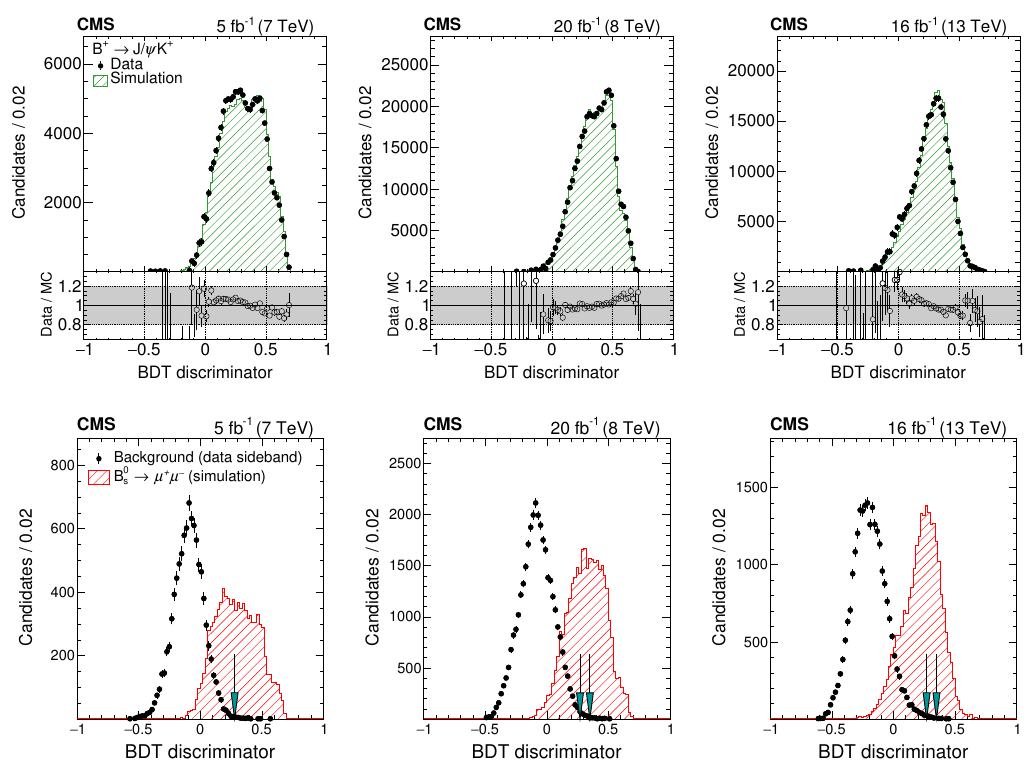
Figure 4 . (Top row) Comparison of the analysis BDT discriminator distributions for B + ! J = K + in background-subtracted data and MC simulation in the central channel for 2011 (left column), 2012 (middle column), and 2016B (right column). The lower panels display the ratio of the data to the MC simulation. The band in the ratio plot illustrates a (cid:6) 20% variation. (Bottom row) Illustration of the analysis BDT discriminator distribution in dimuon background data from the 5 : 45 < m < 5 : 9 GeV sideband and B 0 ! (cid:22) + (cid:22) (cid:0) signal MC simulation. The distributions s (cid:22) + (cid:22) (cid:0) correspond to the full preselection and are normalized to the same number of entries. The solid markers show the data and the hatched histogram the MC simulation. The arrows show the BDT discriminator boundaries provided in table